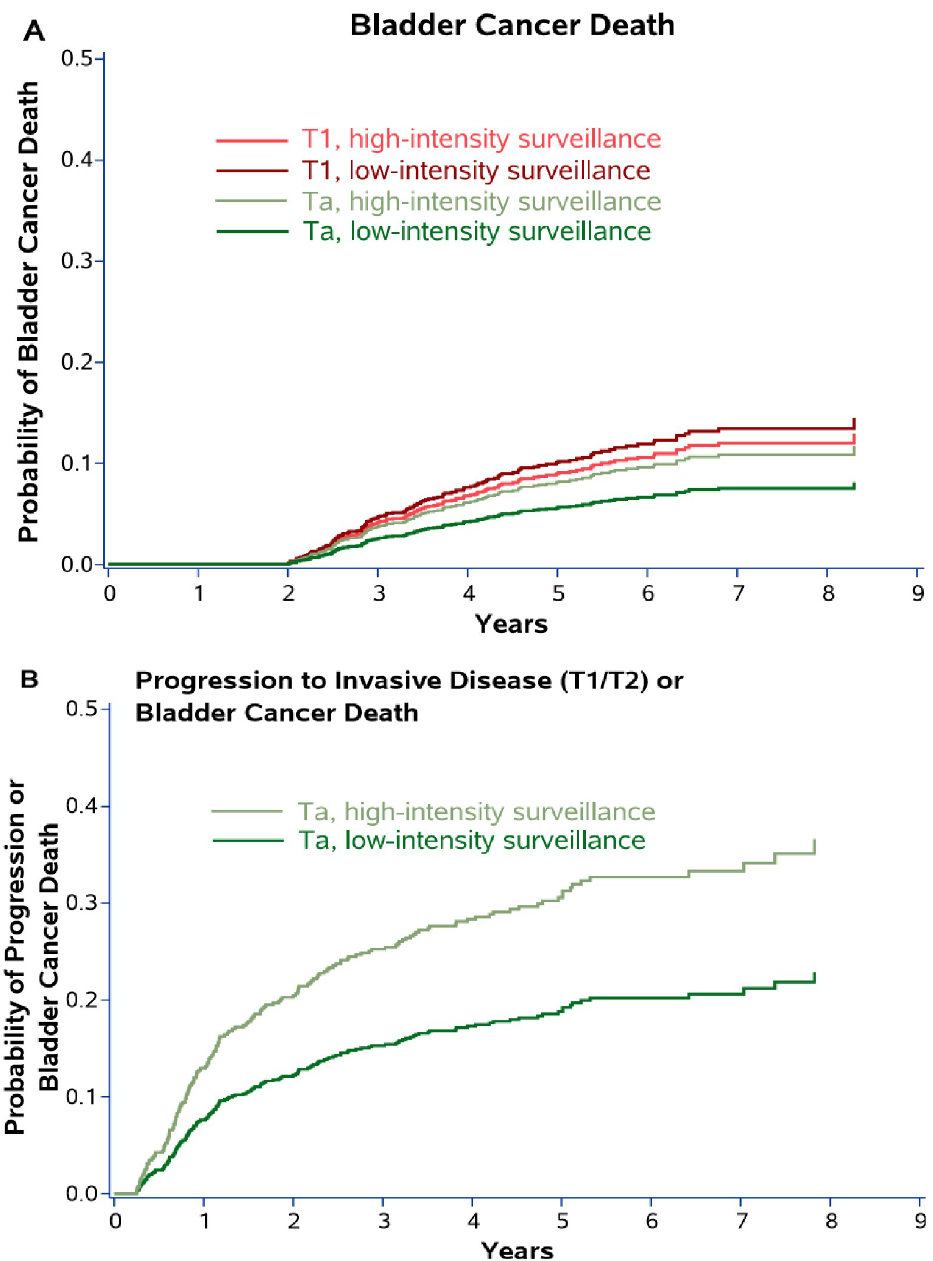
Fig 3. Cumulative incidence plots showing the probability of 1) bladder cancer death by Ta versus T1 disease and by cystoscopic surveillance intensity (Panel A) and 2) progression to invasive disease (T1 or T2) or bladder cancer death among those with Ta disease (Panel B). Data are from Fine and Gray competing risk models adjusted for propensity score and receipt of intravesical therapy with death from other causes modeled as a competing risk.